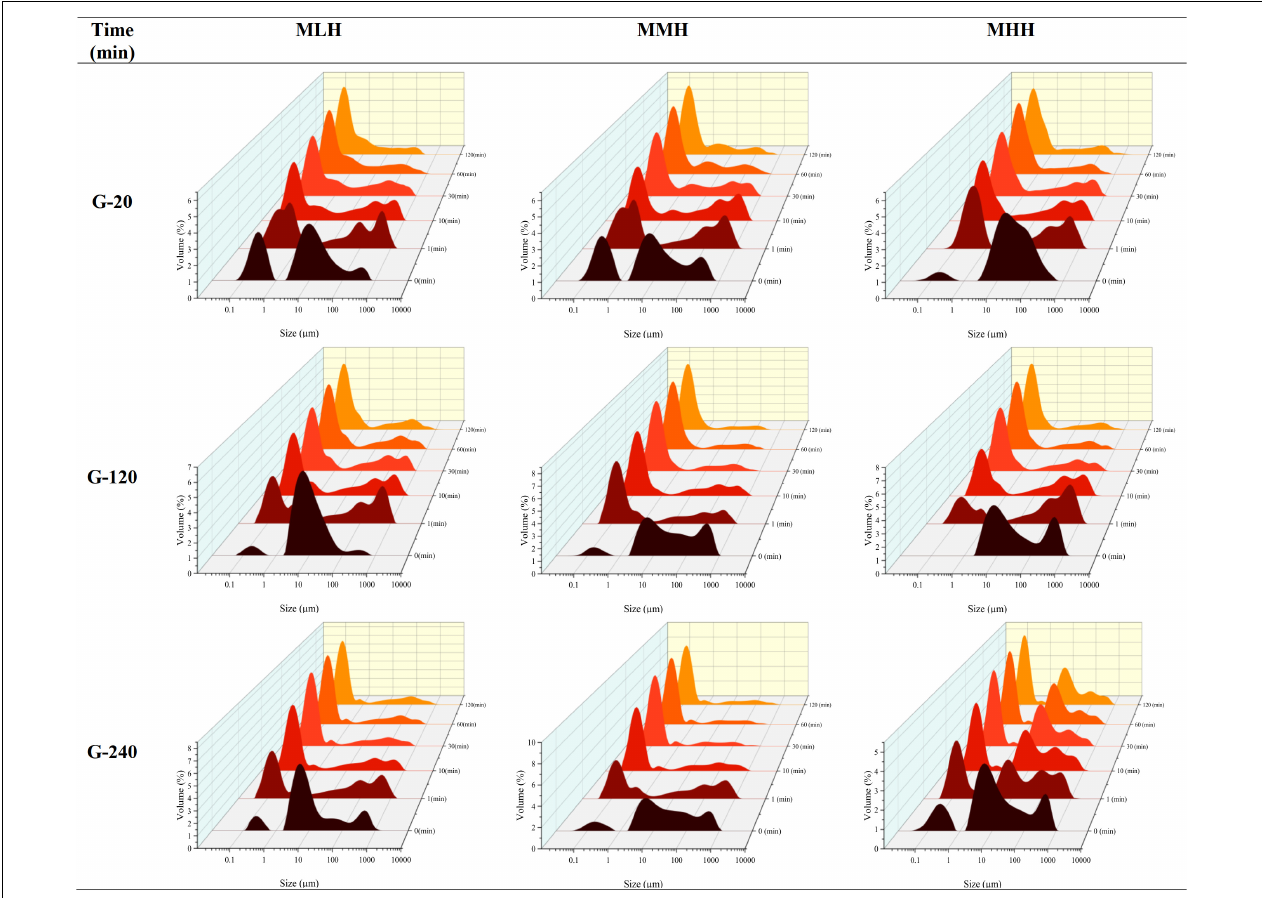
FIGURE 5 | Changes in particle size distribution of emptied gastric digesta (20, 120, and 240 min) before (0 min) and during the intestinal digestion of MLH, MMH, and MHH at different times (1, 10, 30, 60, and 120 min).